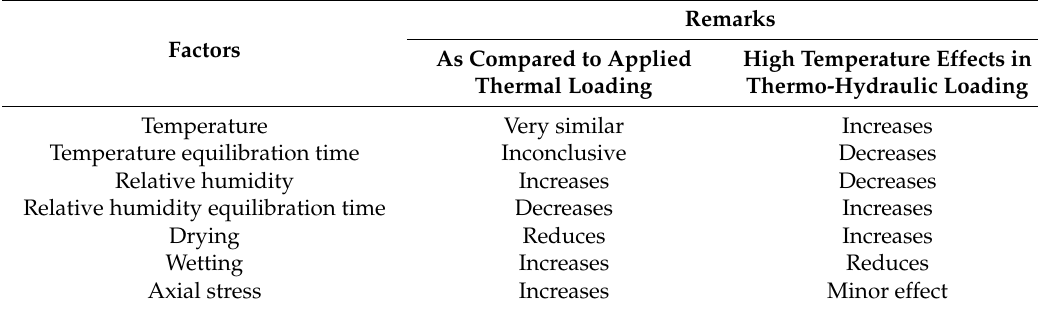
Table 5. Impact of thermo-hydraulic loading on compacted